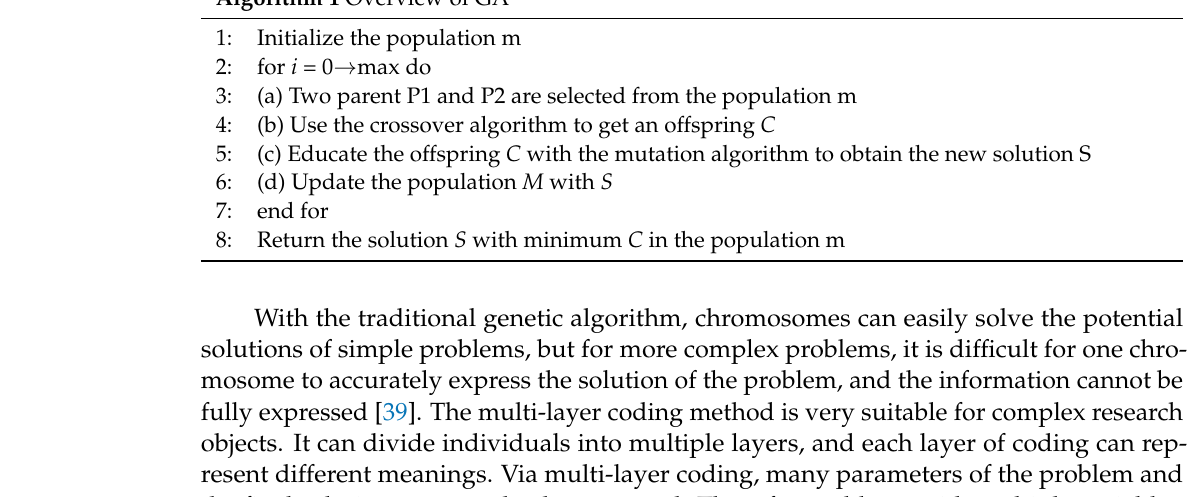
Figure 2. Flowchart of scheduling algorithm for apron support vehicles. Algorithm 1 Overview of